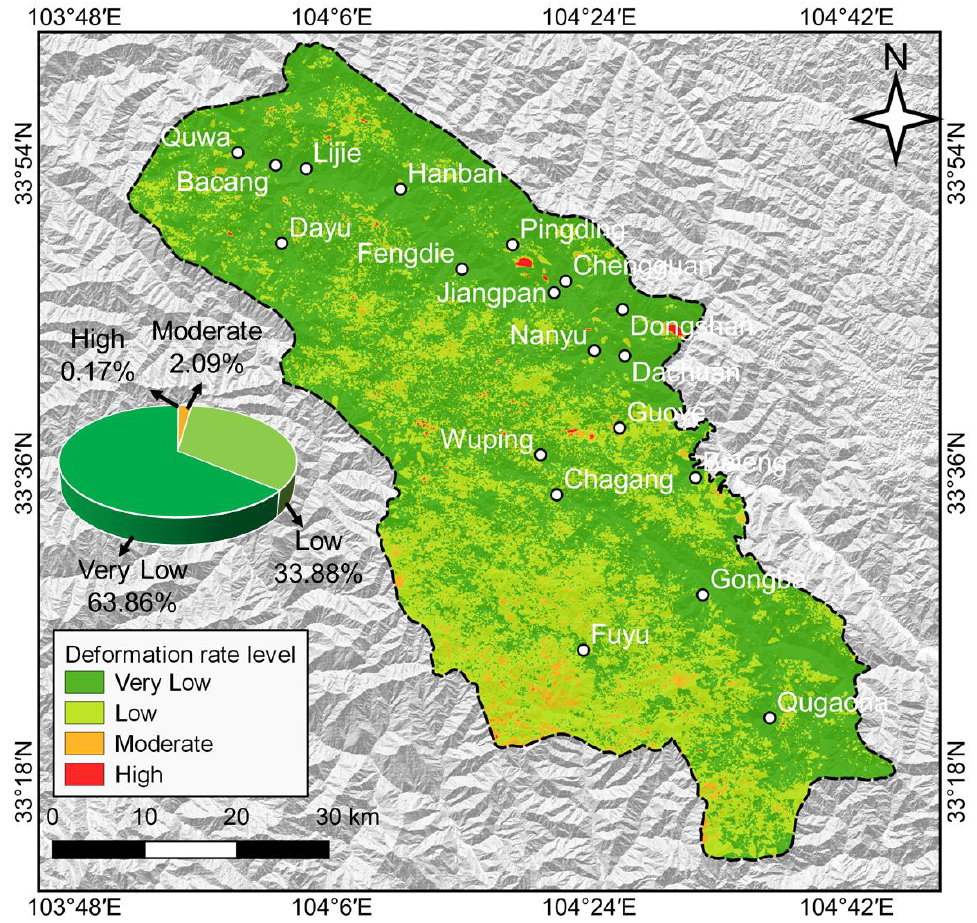
Figure 14. Deformation rate levels in Zhouqu.